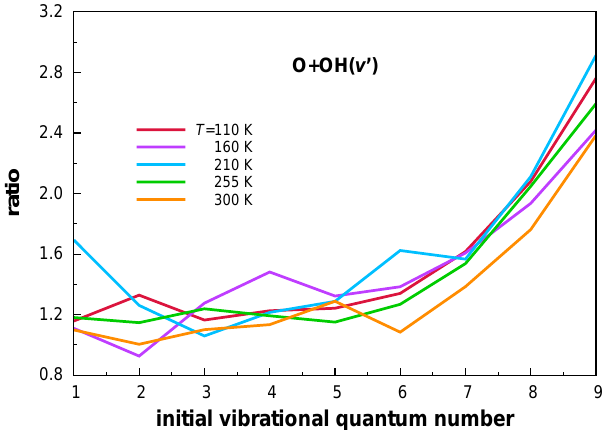
Fig. 1. Ratios between reactive and total vibrational relaxation as a function of the initial vibrational state of the hydroxyl molecule and temperature.